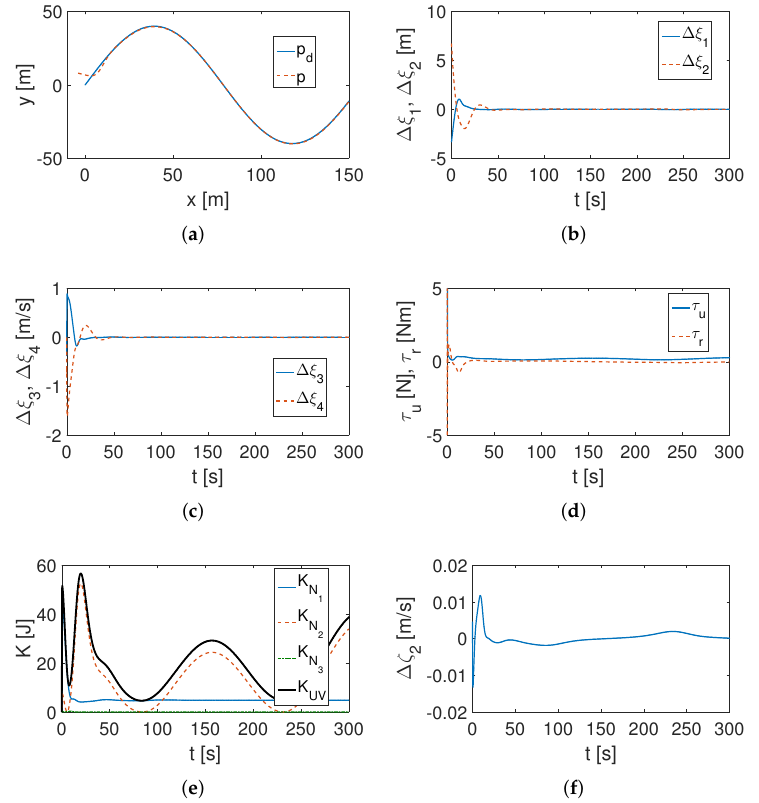
Figure 8. Simulation results for XX AUV QV controller and sine trajectory: ( a ) desired and realized trajectory; ( b ) position error states; ( c ) velocity error states; ( d ) applied force and torque; ( e ) kinetic energy time history; and ( f ) error ∆ ζ 2 .